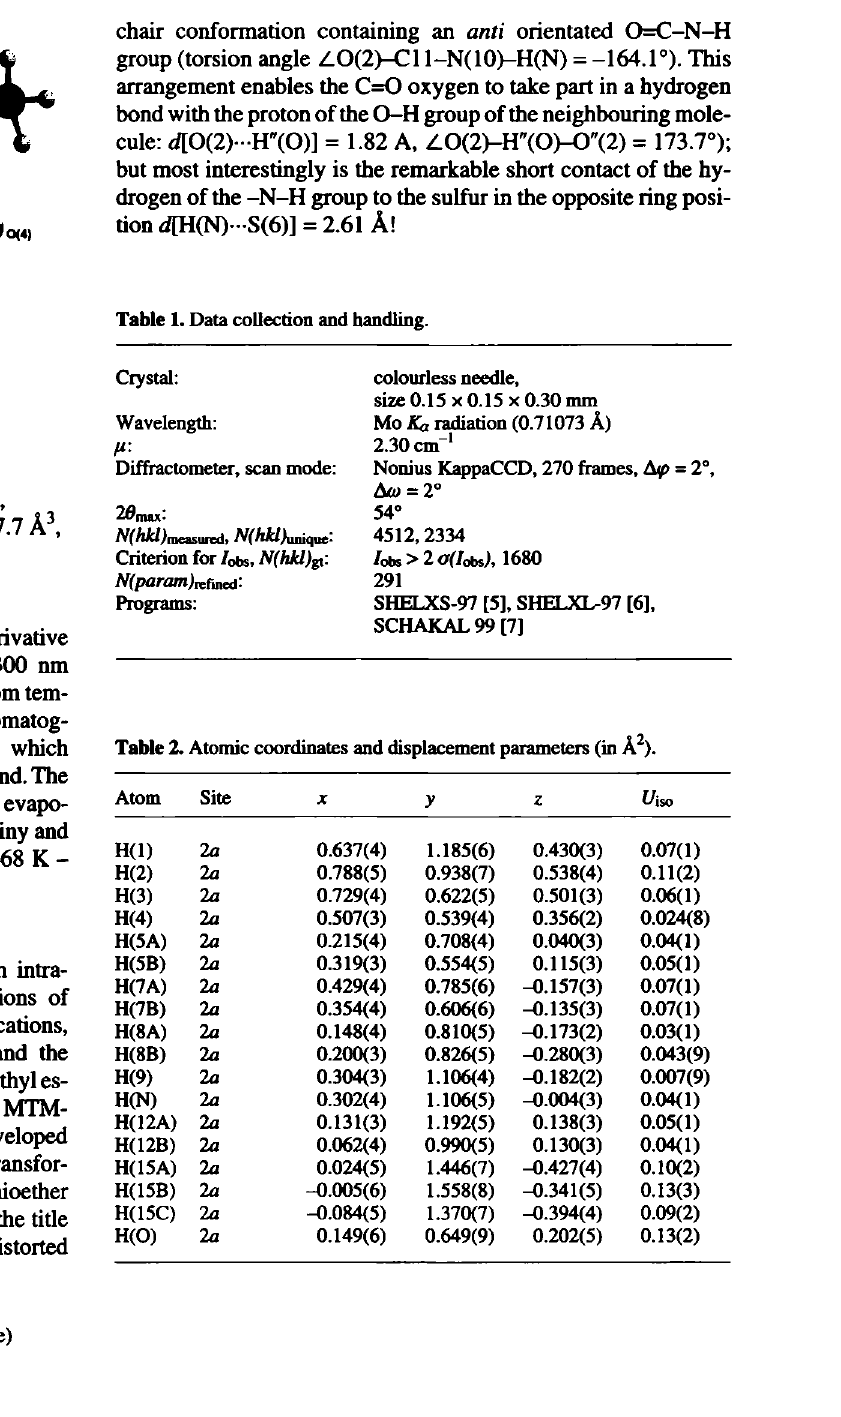
Table 2. Atomic coordinates and displacement parameters (in Â 2